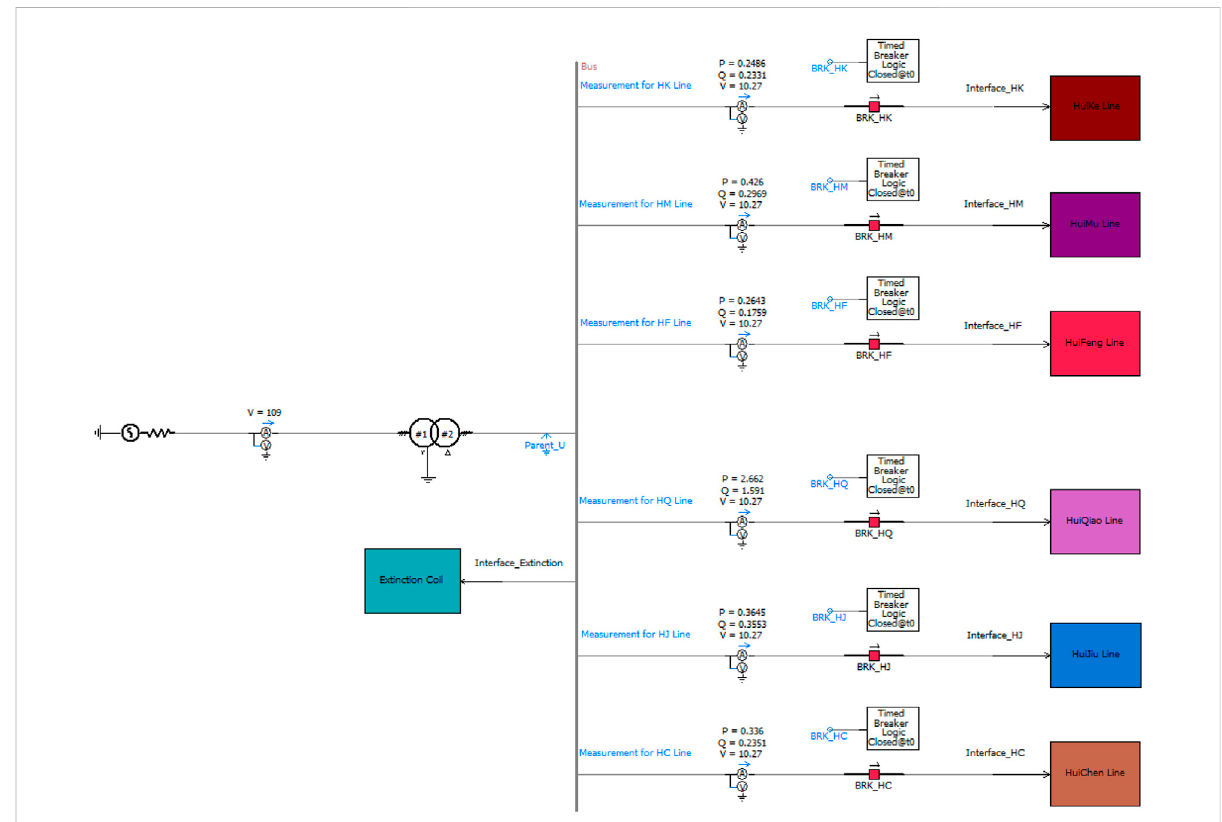
FIGURE A1 Single-phase grounding fault simulation system of a distribution network based on PSCAD.